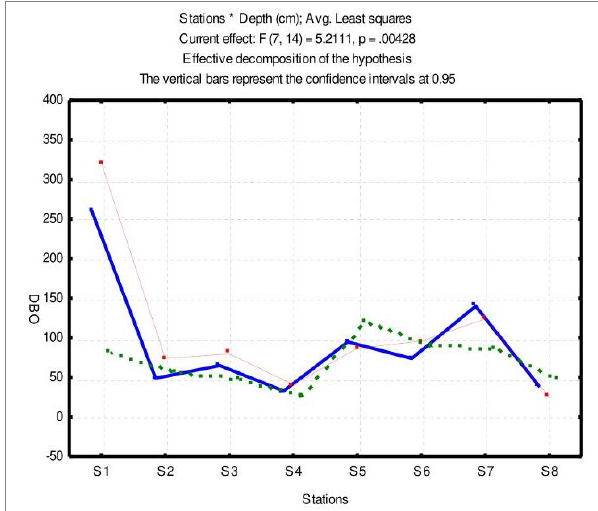
Figure 6. Spatial variation of BOD in mg/l in Reghaia Lake.